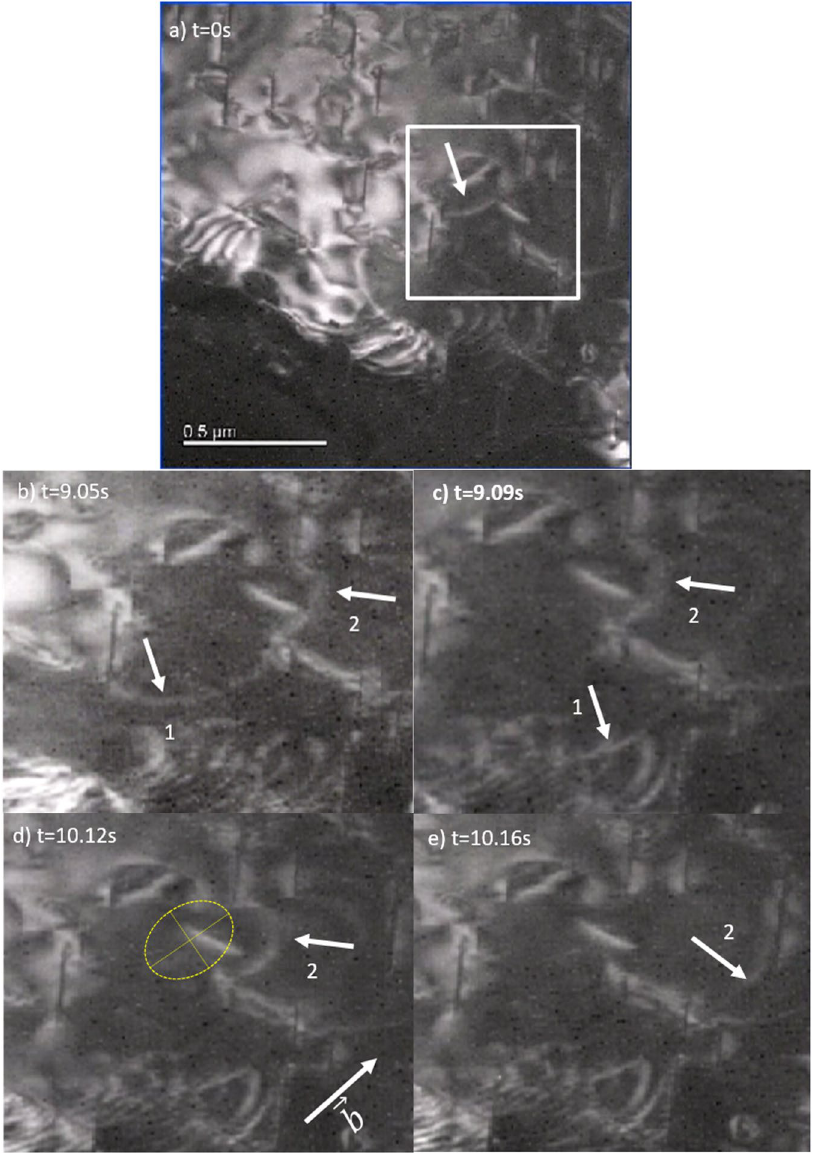
Figure 1. TEM images of dislocation glide on the basal plane. The region in Fig. 1b,c,d,e are from the marked region in Fig. 1a. The time interval between ( b ) and ( c ), ( d ) and ( e ) is very short (one frame 0.04 s) recording the dislocation propagation for both segments. Frame ( d ) shows an elliptical shape of the bowed dislocation segment